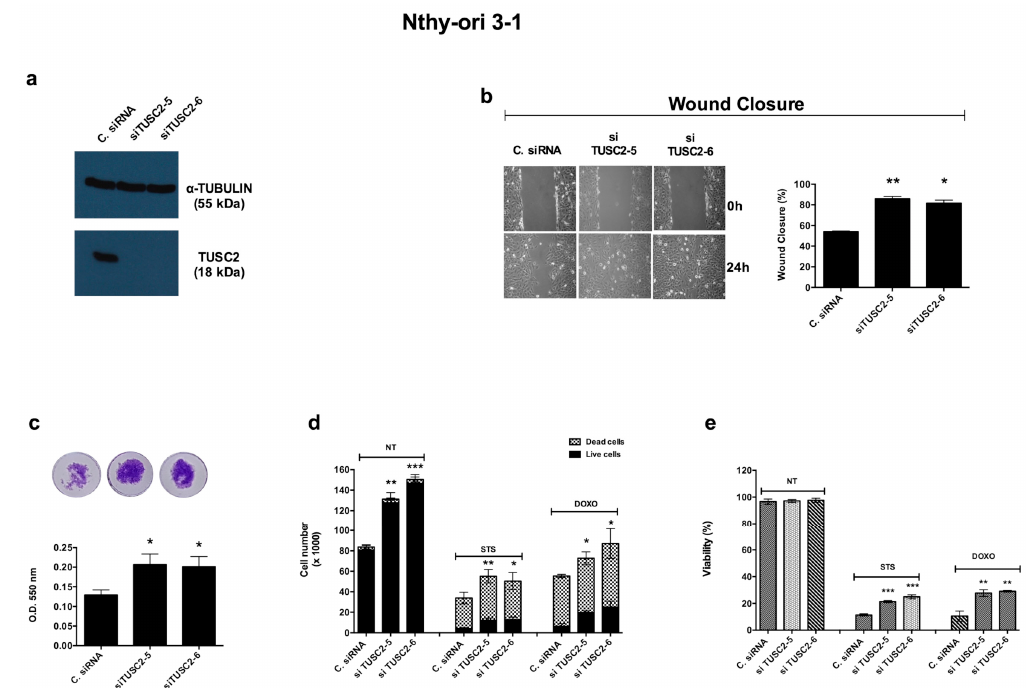
Figure 6. TUSC2 silencing increased the malignant phenotype of the Nthy-ori 3-1 cell line. ( a ) Nthy-ori 3-1 cells were transiently transfected with two di ff erent siRNAs (siTUSC2-5 or siTUSC2-6) or with Control siRNA (named C. siRNA). After 72 h, protein lysates were subjected to immunoblotting with the indicated antibodies. ( b ) Twenty-four hours post transfection, a wound was generated on a confluent monolayer of Nthy-ori 3-1 transfected cells. Cells were imaged (left) under a microscope at 10x magnification and the wound closure distance was quantified by calculating pixel densities in the wound area and expressed as the percentage of wound closure (right). ( c ) The day after the transient transfection, cells were seeded in the upper chambers of the Transwell and allowed to invade the Matrigel matrix for 24 h. Invasion ability is expressed as absorbance at O.D. 550nm. ( d , e ) The Nthy-ori 3-1 cell line was transiently transfected with the indicated siRNA and, the day after, the cells were treated with 1 µ M of DOXO (for 48 h) or with 2.5 µ M of STS (for 24 h). At the end of the treatment, cells were stained with trypan blue and counted ( d ) and the percentages of cells viability ( e ) were determined. Values represent the average of duplicate experiments ± standard errors. * p < 0.05, ** p < 0.01 and *** p < 0.001.